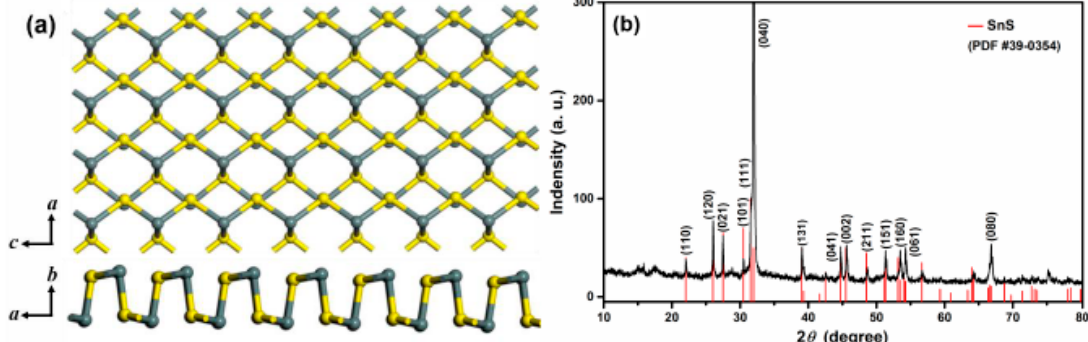
Figure 3. ( a ) Crystal structure diagram of orthorhombic phase SnS. ( b ) XRD pattern of typical SnS nanosheets.